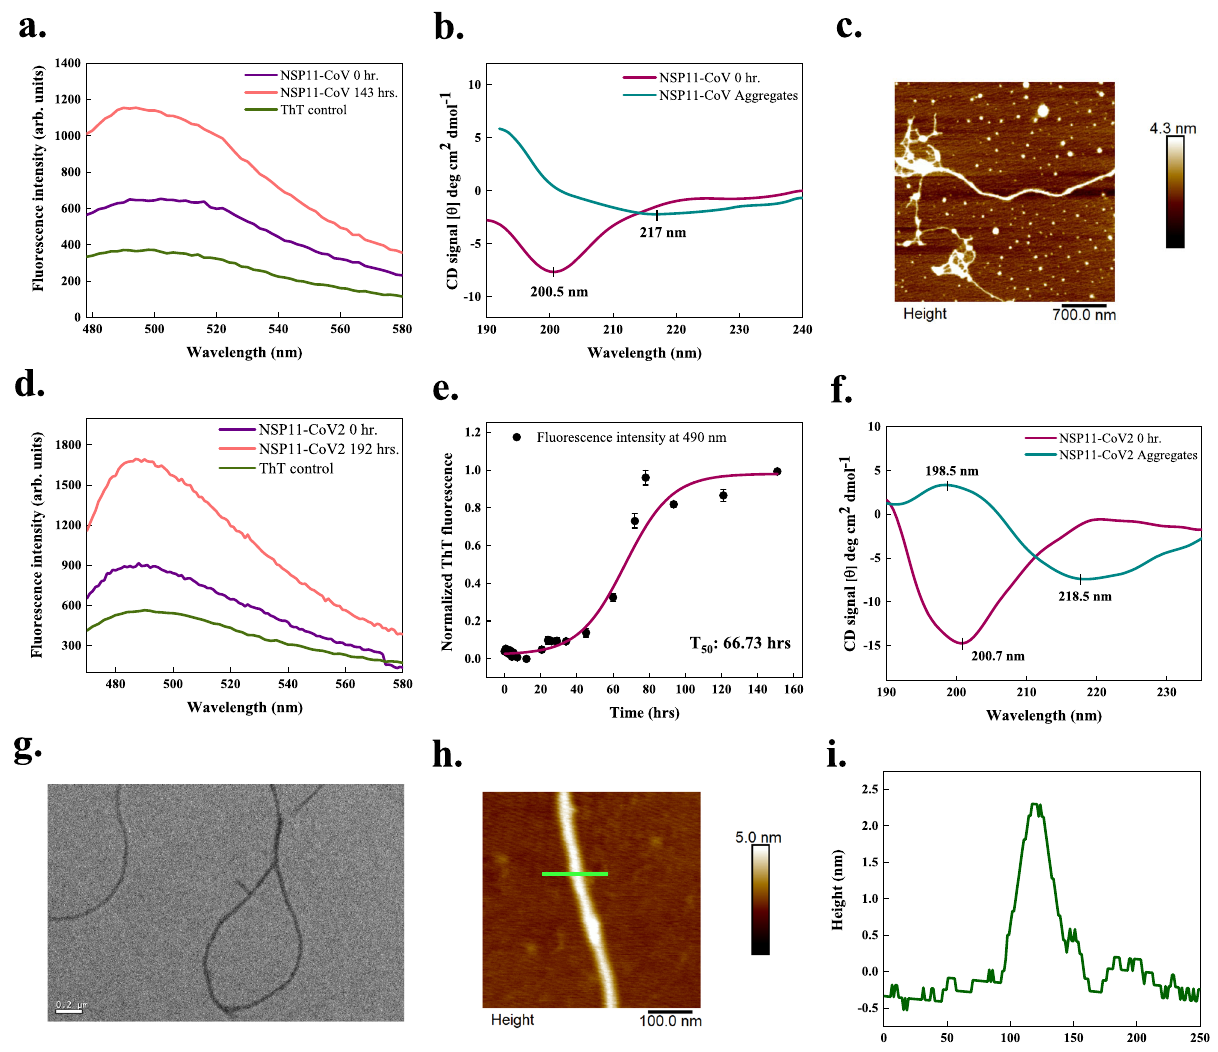
fi brils (192h) is observed using tapping-mode AFM where the scale bar represents 700 and 100nm, respectively. Five micrographs were captured from same sample foreachpeptideaggregate. e AggregationkineticsofNSP11-CoV2,monitoredusing ThT fl uorescence. Each dotted symbol represents the average value of three technicalreplicatesand errorbarrepresentstheSEMofthesereplicates.Thewine- coloured line shows the sigmoidal fi tting of data points that determines the T 50 of this reaction to be 66.73±2.84h. g Under HR-TEM, the NSP11-CoV2 fi brils appear unbranched at 192h; the scale bar represents 200nm. Fifteen micrographs were capturedfromthesamegrid. i Heightpro fi leofanNSP11-CoV2amyloid fi brilshown with green-coloured line in panel ( h ). Additional micrographs and height pro fi les aregiveninSupplementaryFig.4.ThesourcedataaregivenintheSourceData fi le. Arb. units are arbitrary